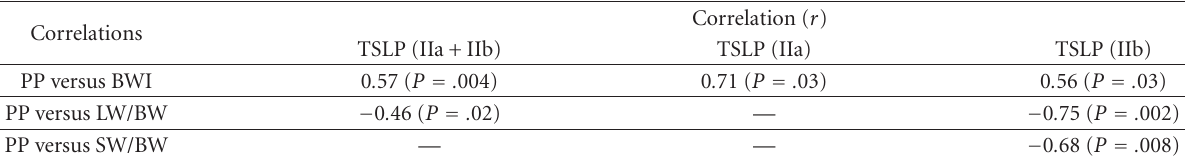
Table 3. Correlations between portal pressure and body weight increase and liver and spleen weights in rats with triple stenosing ligation of portal vein (TSLP) (Group II) which, in turn, were divided into Group IIa (spleen weight/body weight < 0 . 29) and Group IIb (spleen weight/body weight ≥ 0 .